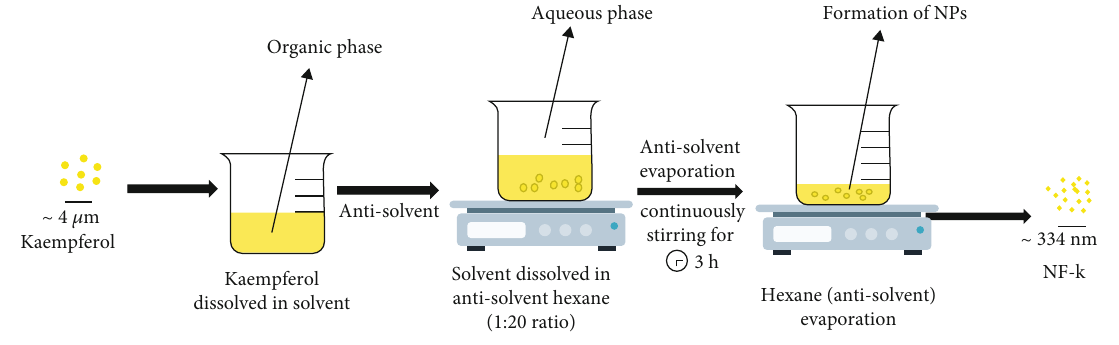
Figure 1: Schematic representation of synthesis of NF-k.